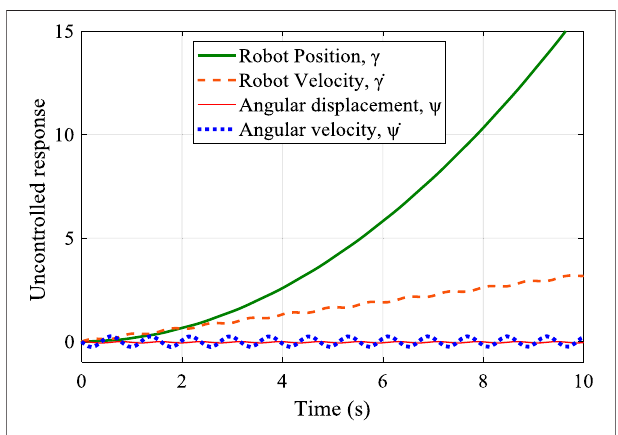
FIGURE 8 | Performance comparison of TDC, iTDC, and iTDC + PPC. (A) Control signal of TDC and iTDC showing the improved smooth signal of iTDC; (B) Position tracking of the robot showing the unstable response of TDC; (C) Linear velocity; (D) Sway angle of the arm showing the weak sway control of PPC.